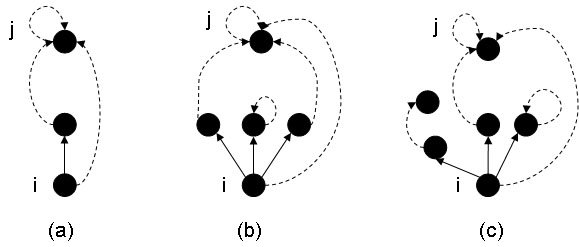
Propagation. Propagation procedure after the initialization, updates the start_path pointers. pred edges are represented as continued arrows, start_path pointers are represented as broken arrows.(a) If start_path[i] points to a node different from i (e.g. a predecessor of i) and different from start_path[start_path[i]] = j, then we assign start_path[i] = j. (b) If i has all the predecessors with start_path pointers pointing to themselves or predecessors with start_path pointing to the same node j, then we assign start_path[i] = j. (c) If all the predecessors of i have the start_path pointers cycling on themselves or start_path pointing to a node without predecessors, we consider the predecessor j having the maximum d s distance and we assign start_path[i]= j.